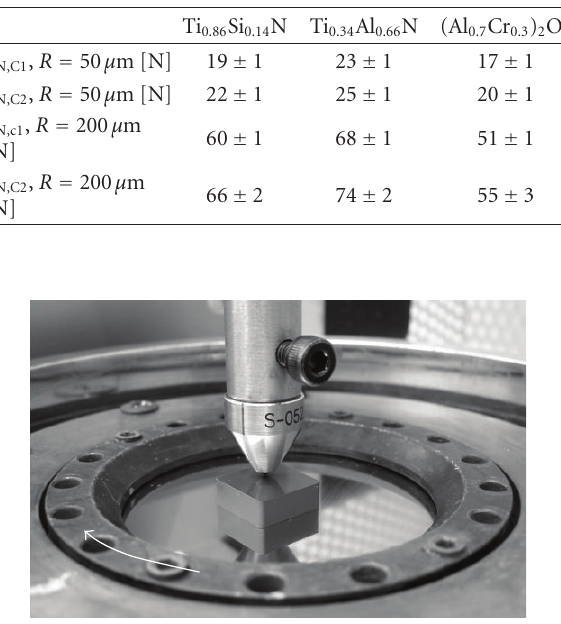
Table 3: Critical normal loads of the coatings investigated for Rock- well C diamond styli with radius 50 μ m and 200 μ m, respectively.